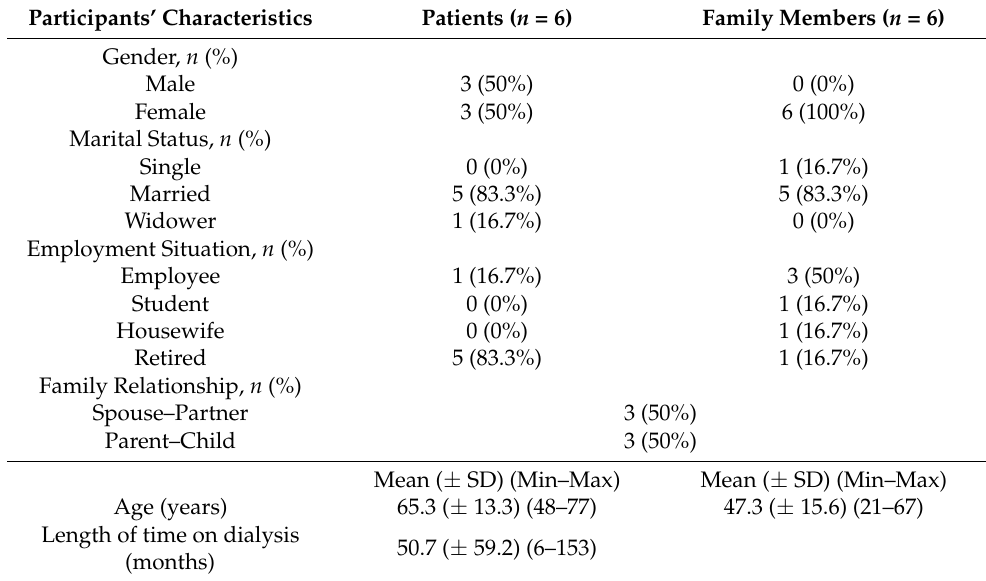
Table 2. Participants’ characteristics ( n =